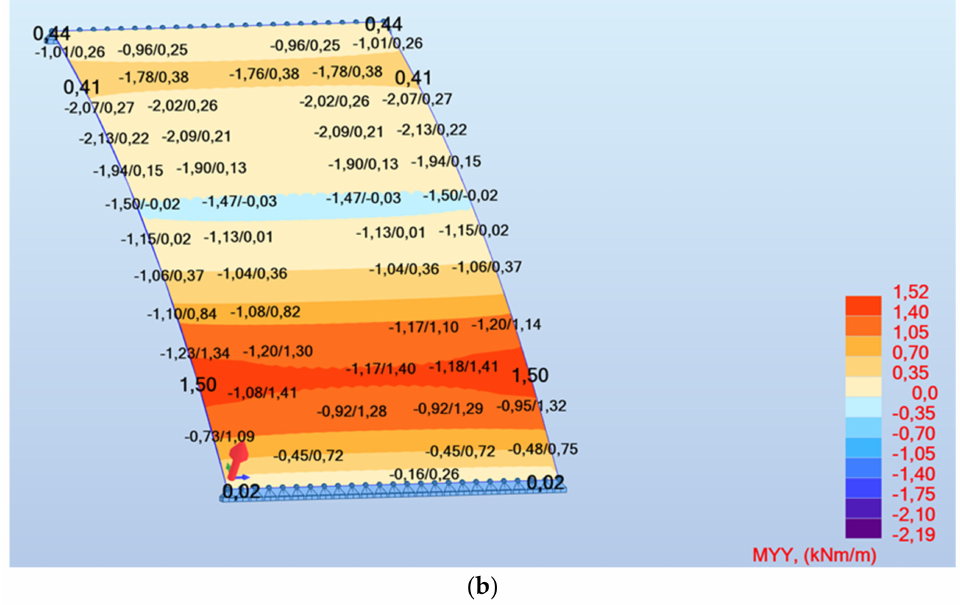
Figure 10. A view of the dialog box ( a ) map of XX moment, ( b ) map of YY moment.